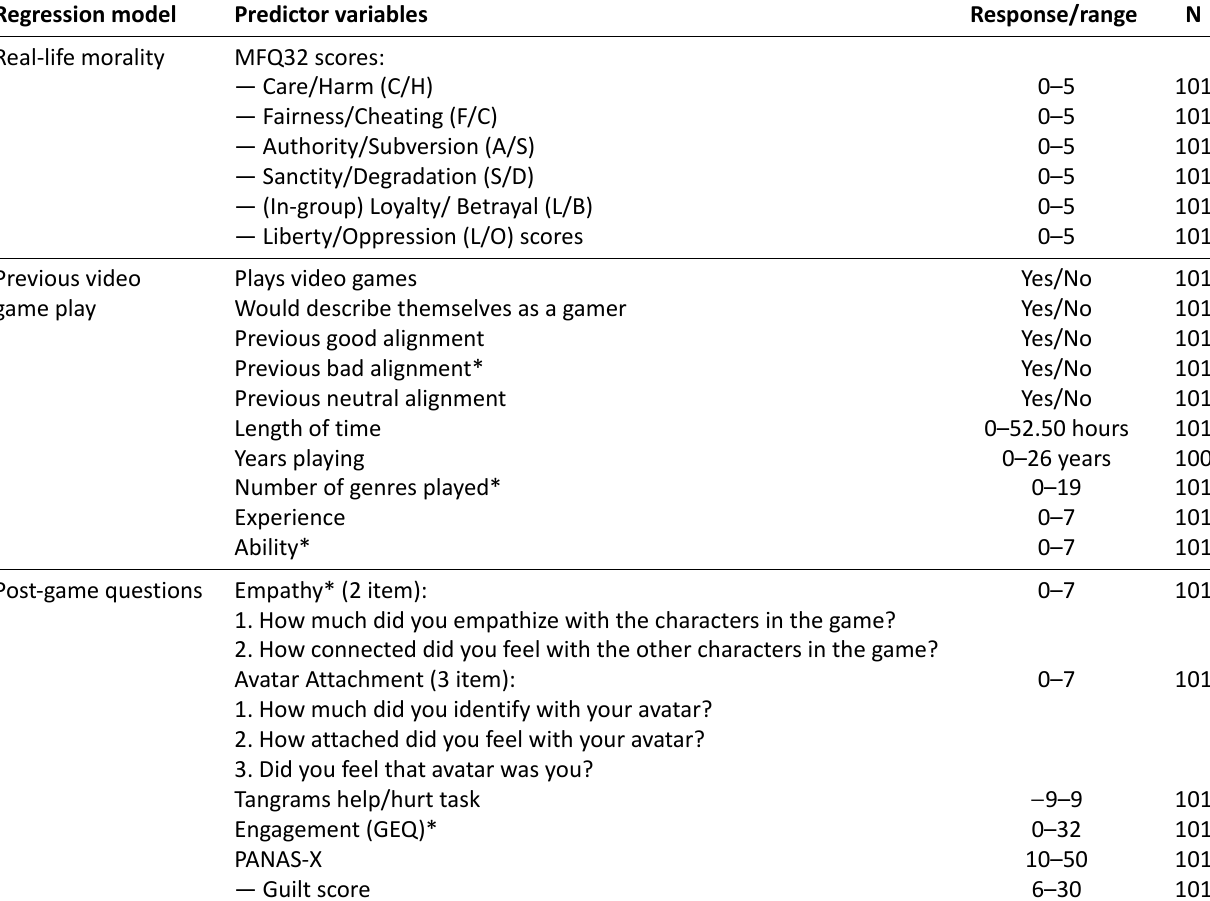
Table 5. Individual predictor variables for the three regression